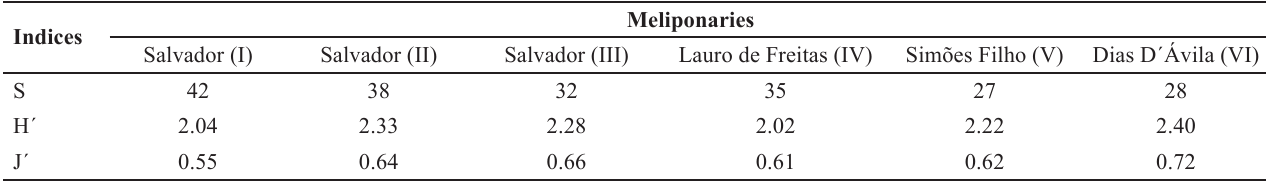
Table 3. Trophic niche width (H’), equitativity (J’) and pollen type richness (S) in honey samples of Melipona scutellaris from highly urban - ized and industrialized sites in the metropolitan region of Salvador, Bahia, Brazil.